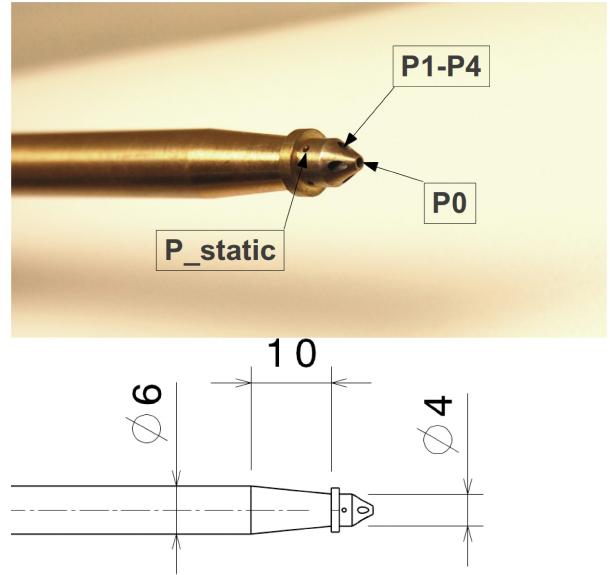
Fig. 2. Probe by ISM Braunschweig, picture and dimensions in mil-